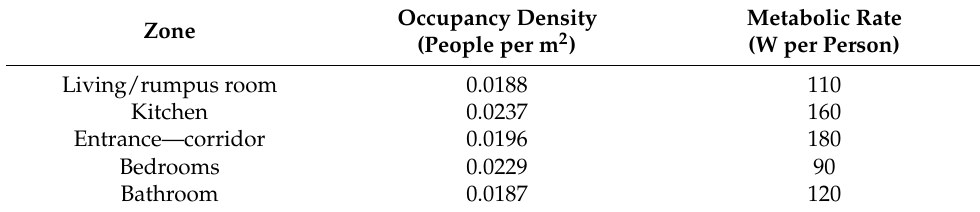
Table 3. Occupancy density and metabolic